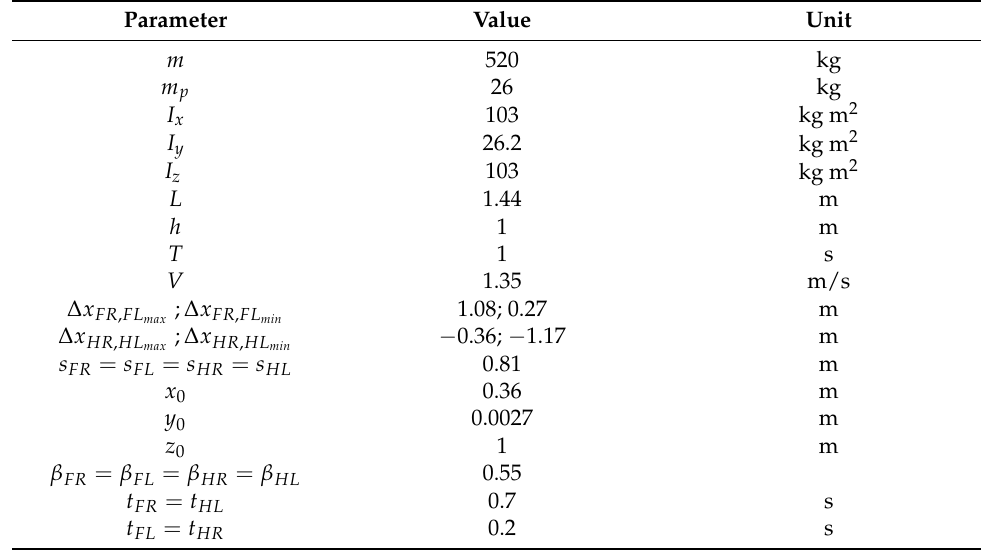
Figure 12. The trend of the coefficient of adhesion for each foot. Table 1. Simulation setting parameters and results.